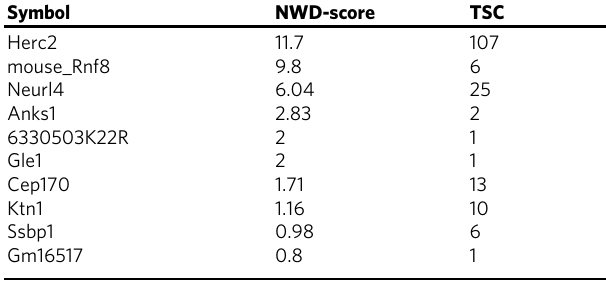
Table 1 RNF8-interacting proteins